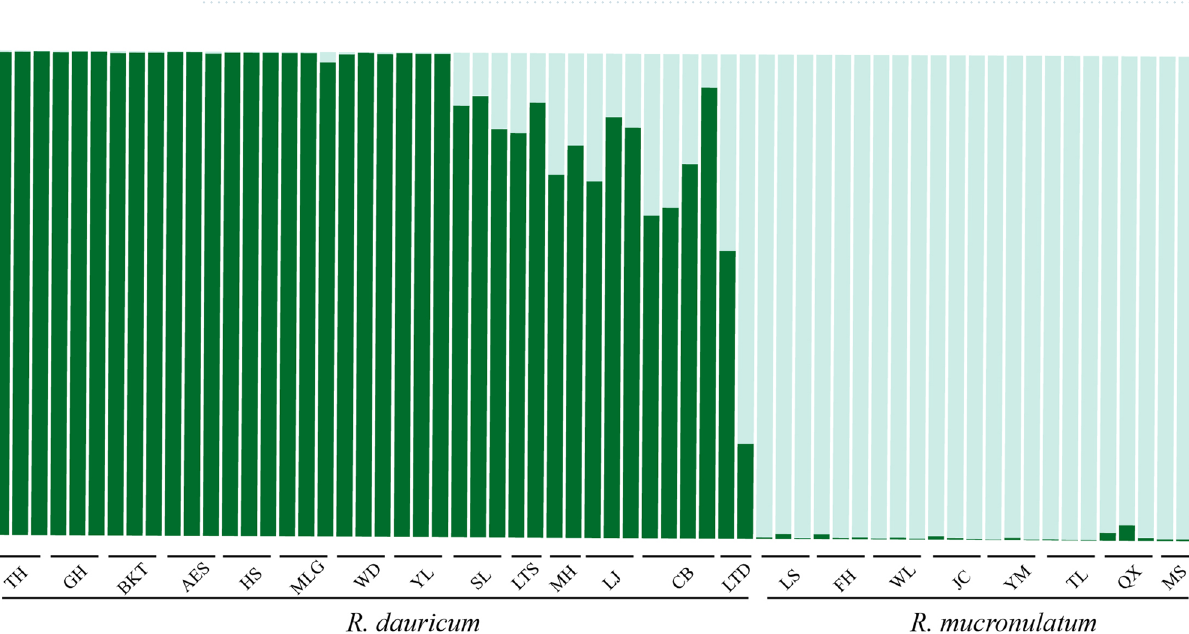
Figure 3. STRU CTU RE results of the populations based 265 markers when K = 2. K = 2 was the most probable number of